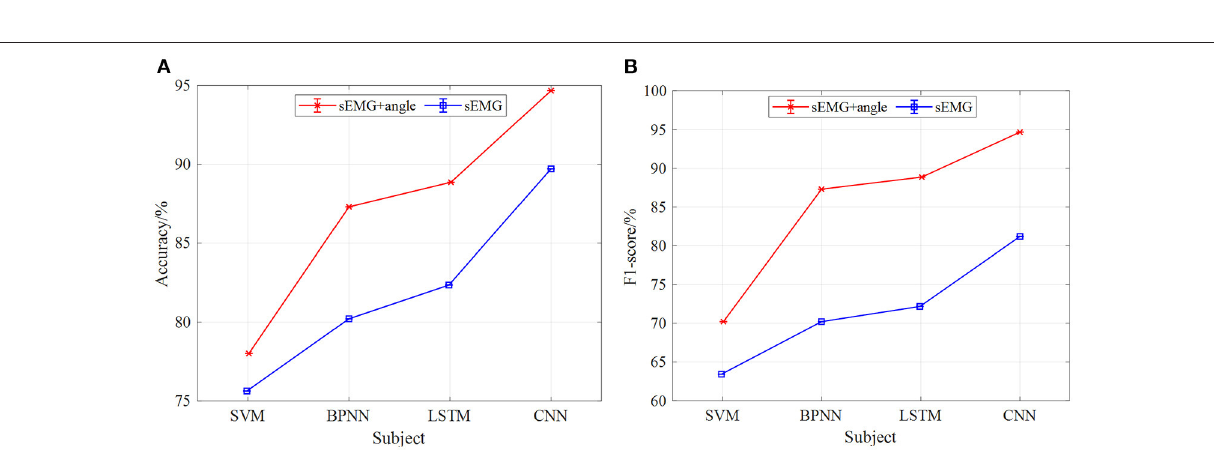
FIGURE 13 | The comparison results of different models of multi-information and single information input with the 5-fold cross-validation method at 1km/h, (A) comparison results of four model accuracy with different input information, (B) comparison results of four models F1-score with different input information.